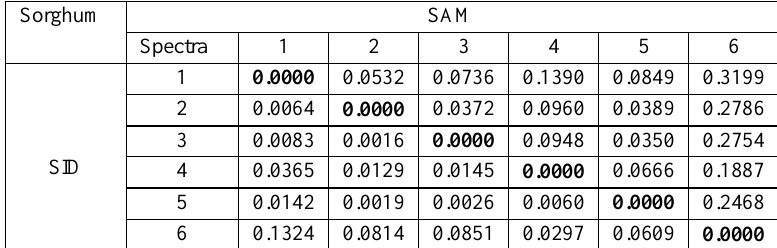
Table 4: SAM and SID among Sorghum field spectra